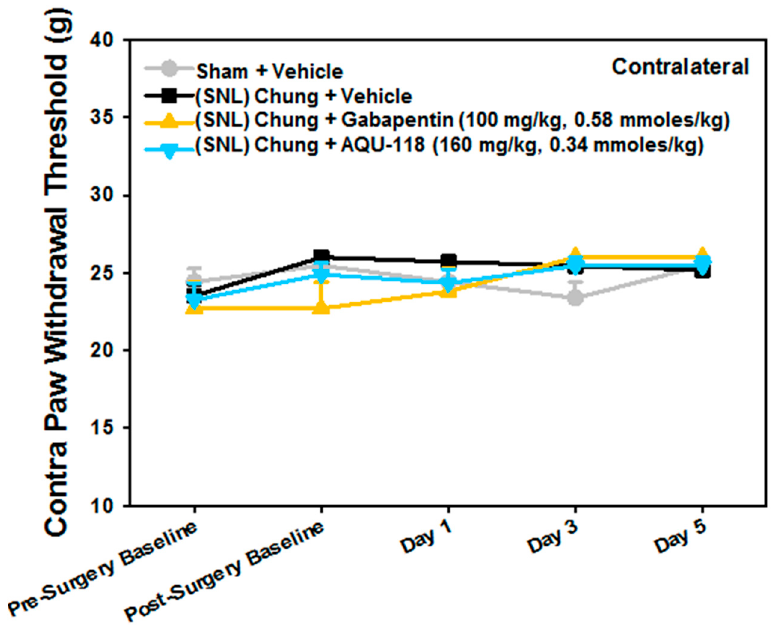
Figure 1. Mechanical Response Threshold: Spinal Nerve Ligation (SNL) Chung Model (Chung), Ipsilateral (Ipsi) Paw Withdrawal. Paw withdrawal thresholds following SNL-surgery for ipsilateral hind paws. Data are presented as mean ± SEM. * p < 0.05 vs. (SNL) Chung + Vehicle group on the same day. Post-Surgery Baseline was performed 15 days after SNL-surgery.